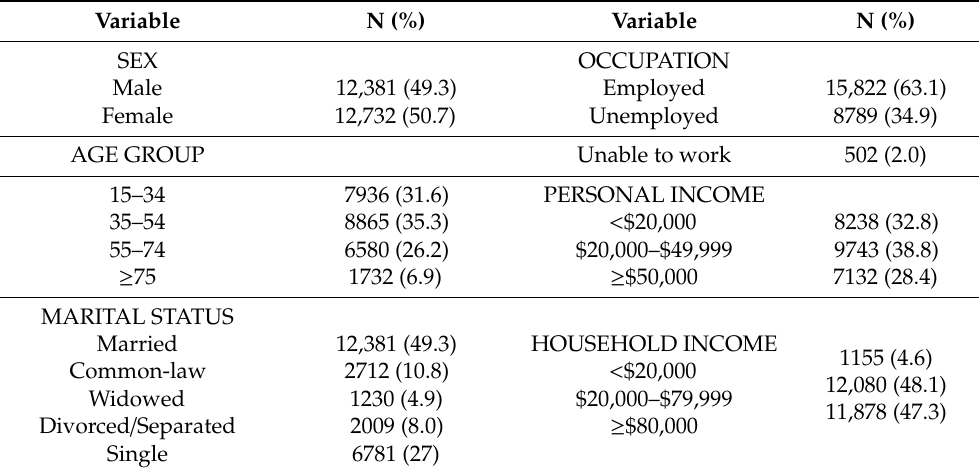
Table 1. Sociodemographic characteristics of the total sample (N =